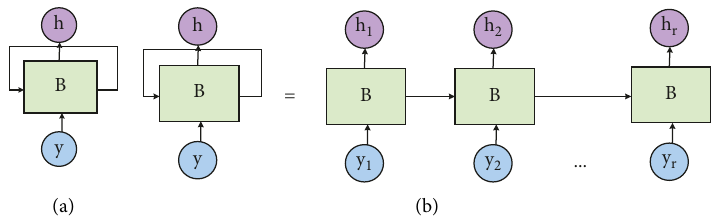
Figure 4: Structure diagram of RNN. (a) RNN neural network structure. (b) Schematic diagram of RNN neural network expansion.